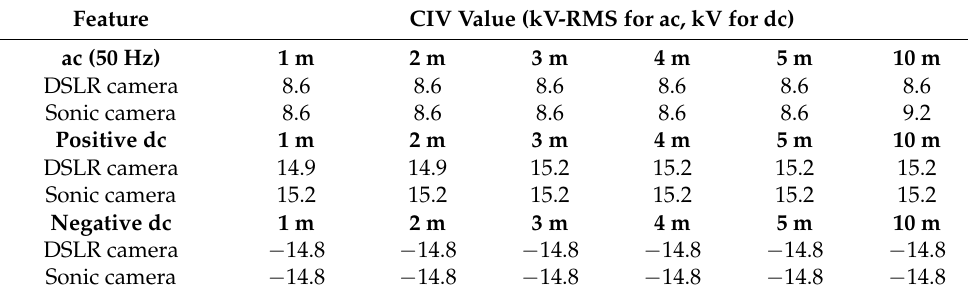
Table 4. CIV values that were obtained with the needle-plane gap.